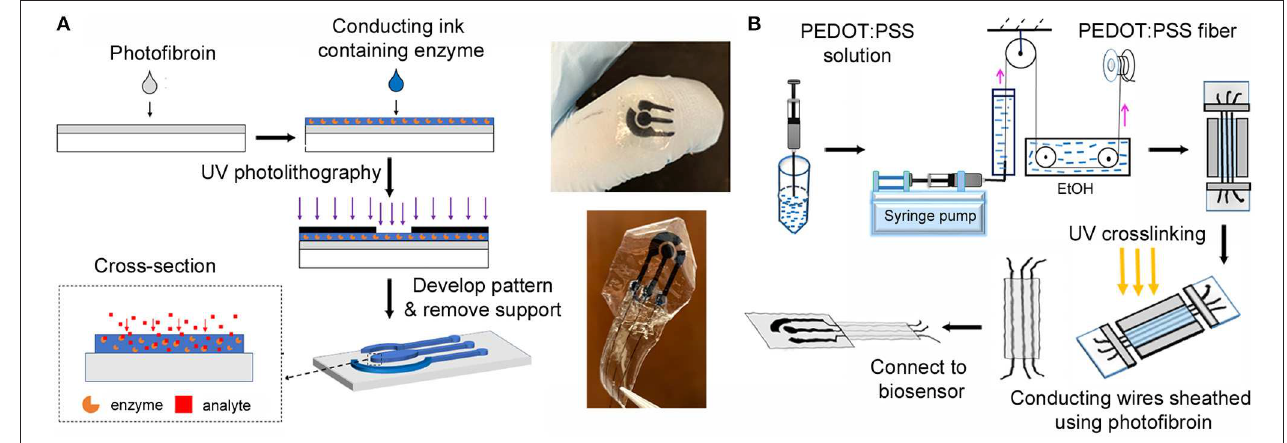
FIGURE 1 | (A) Fabrication of the fully-organic, flexible 3-electrode silk biosensor using photolithography. (B) Fabrication of the fibroin sheathed conducting wires. The images in the center show the biosensor and the connected